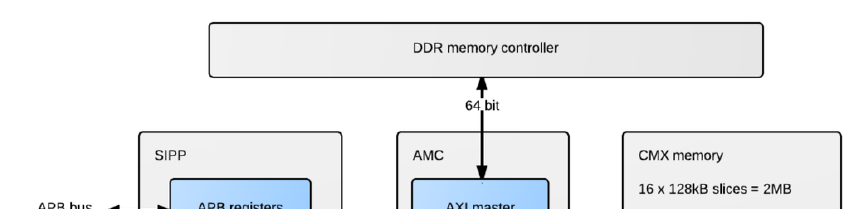
Figure 6. SHAVE internal architecture.